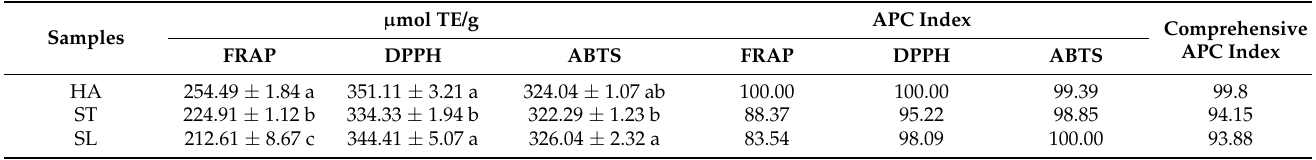
Table 4. Antioxidant activity of ODT samples with different fixing